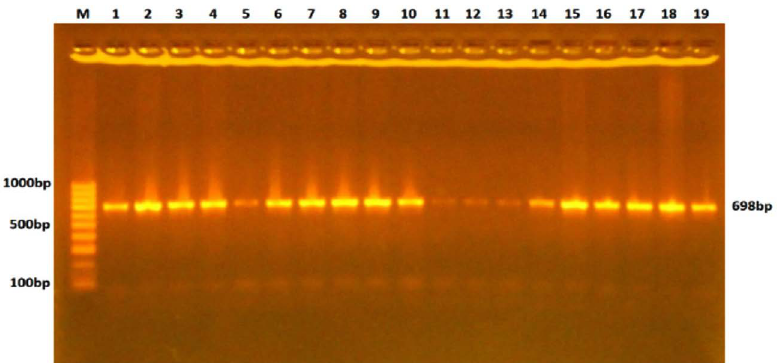
Fig. 1. Gel electrophoresis of TLR-4 gene PCR products stained with ethidium bromide and visualized under the UV light. The fragment length was